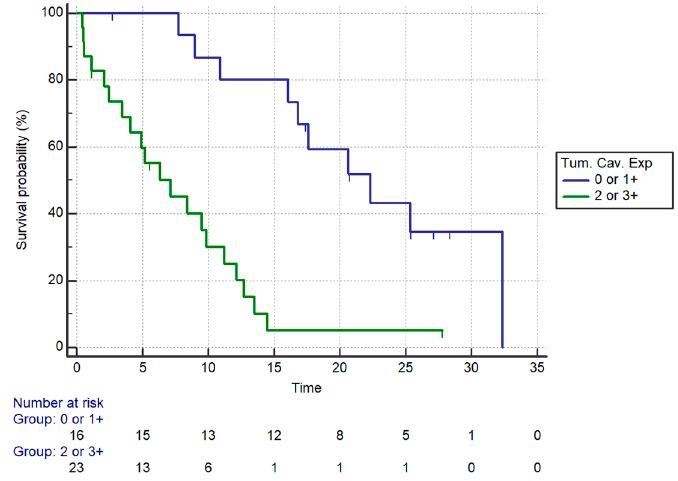
Figure 2. Differences in Caveolin ‐ 1 expression between primary tumor and metastases. ( a ) Differences in Caveolin ‐ 1 ex ‐ pression as a continuous variable. Median % of expression of primary tumor 10% vs. 90% of metastatic samples, p = 0.001. ( b ) Differences in Caveolin ‐ 1 expression by IHC score (0 vs. 1+ vs. 2+ vs. 3+, p = 0.0038).